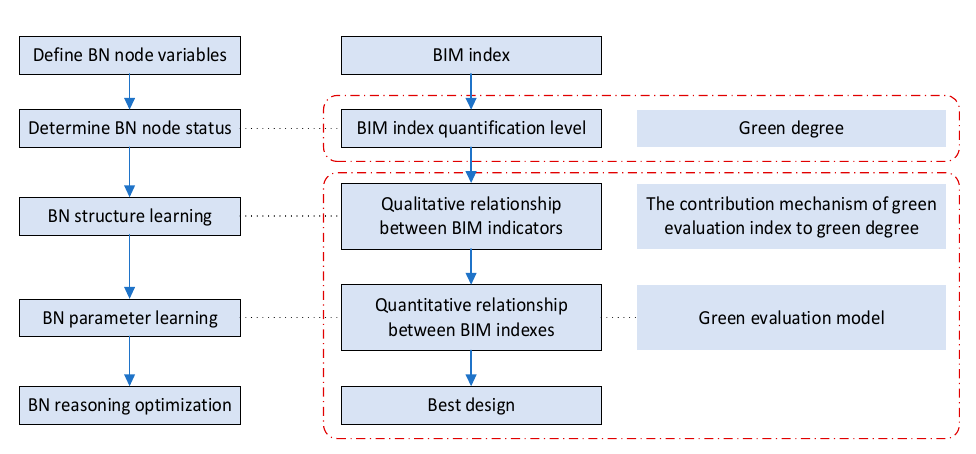
Figure 3. Evaluation method for building interior decoration based on BIM-BN Technology.